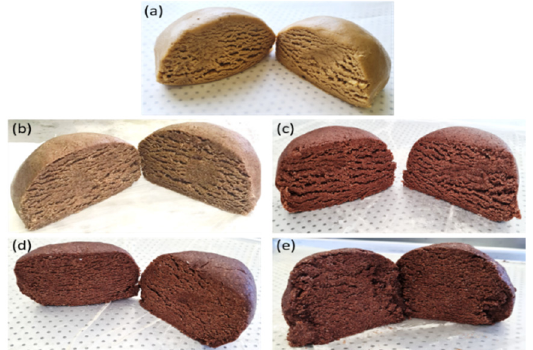
Figure 1. Cookie doughs obtained from formulations with ( a ) 0%, ( b ) 10%, ( c ) 20%, ( d ) 30%, and ( e ) 40% CS flour substituted for wheat flour.